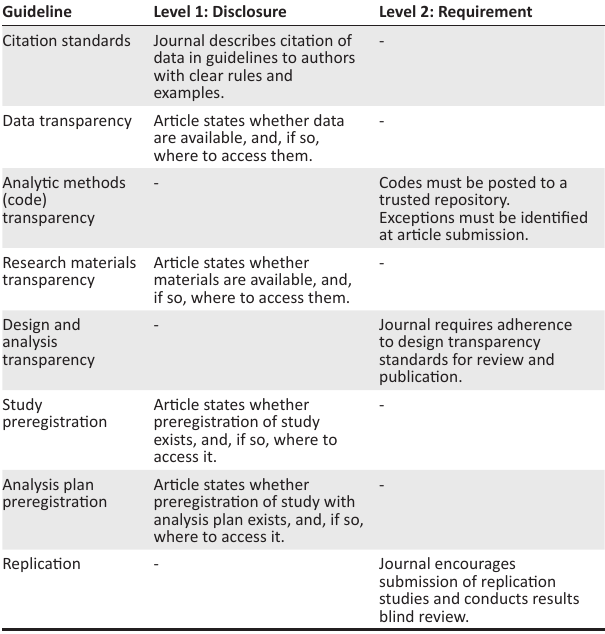
TABLE 2: Promised level of transparency and openness promotion guidelines to be implemented in the South African Journal of Industrial Psychology . Guideline Level 1: